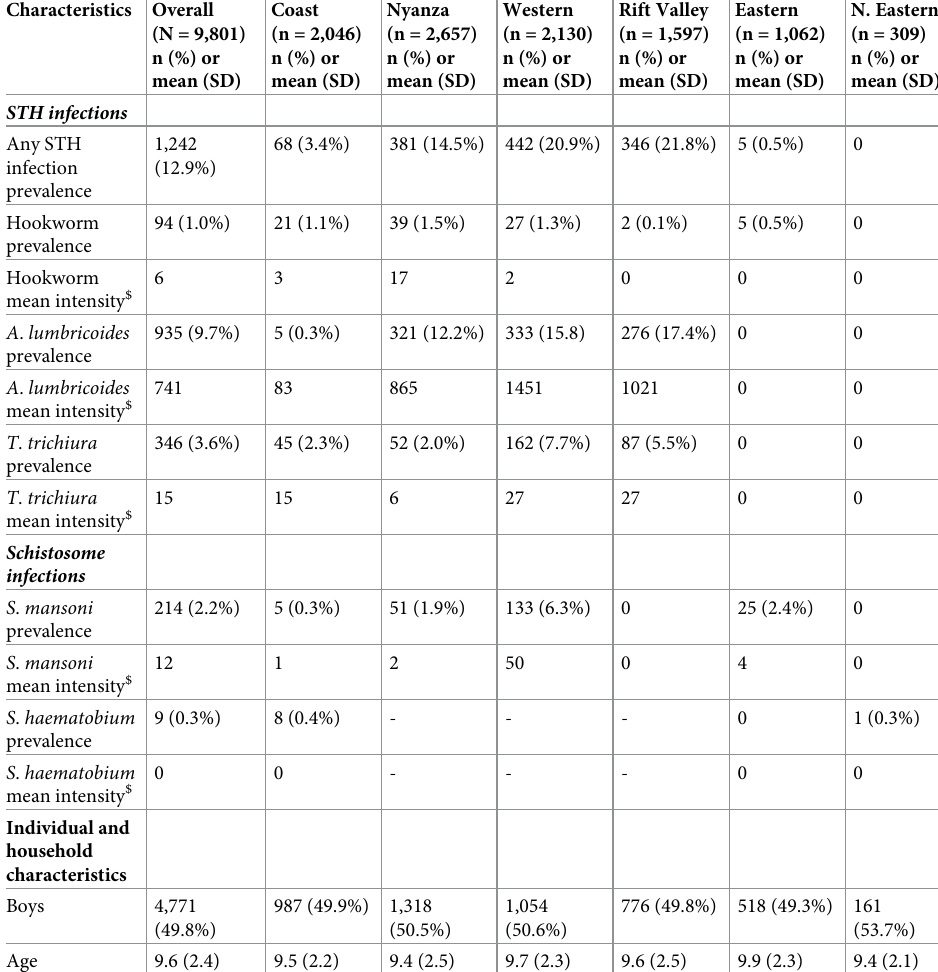
Table 7. Pupil, household and school WASH characteristics overall and stratified by regions in Kenya after five rounds of MDA. Characteristics Overall (N = 9,801) n (%) or mean